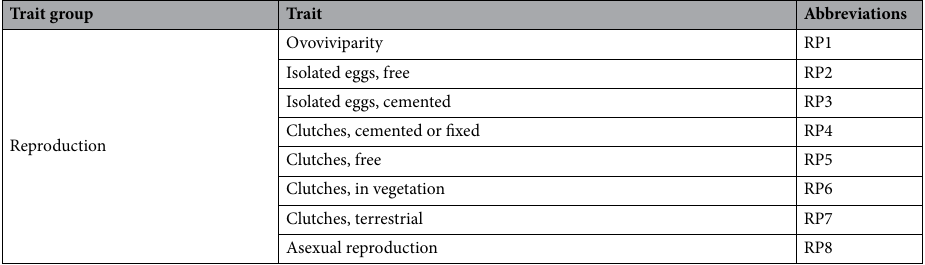
Table 4. List of functional trait groups and functional traits used in our